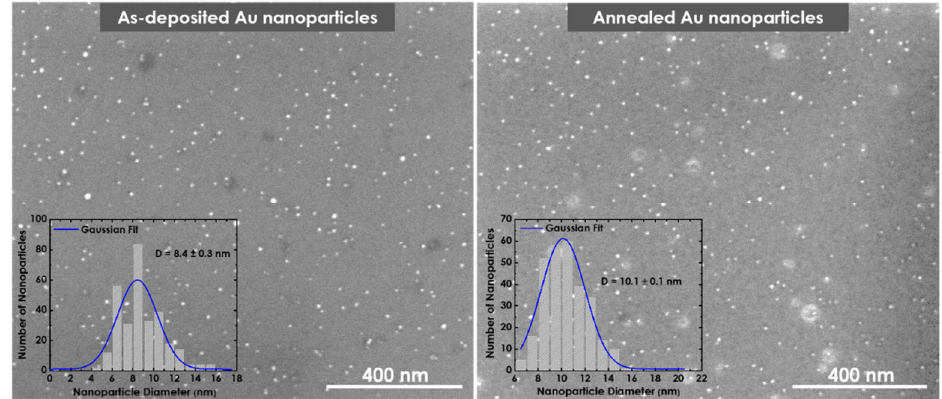
Figure 7. SEM micrographs of Au nanoclusters before and after annealing at 700 °C for 20